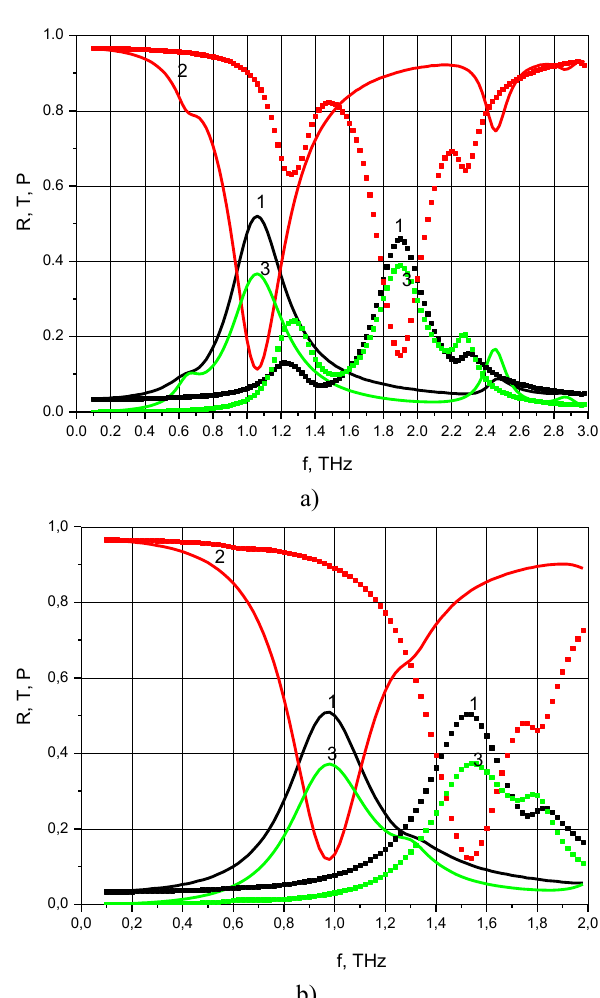
Fig. 3. Frequency dependences of the reflection, transmittance coefficients and losses in the resonance metasurface of two connected identical rectangular graphene strips in the unit cell on the dielectric substrate: a) d =1 μ m; b) d =10 μ m; curves 1 — R , 2 — T , 3 — P; W 1 = W 2 = 25 μ m, l 1 = l 2 = 50 μ m; μ c = 0.25 eV. Solid lines s-polarization, dashed lines p -polarization of incident TEM -wave. Other parameters are as in Fig.